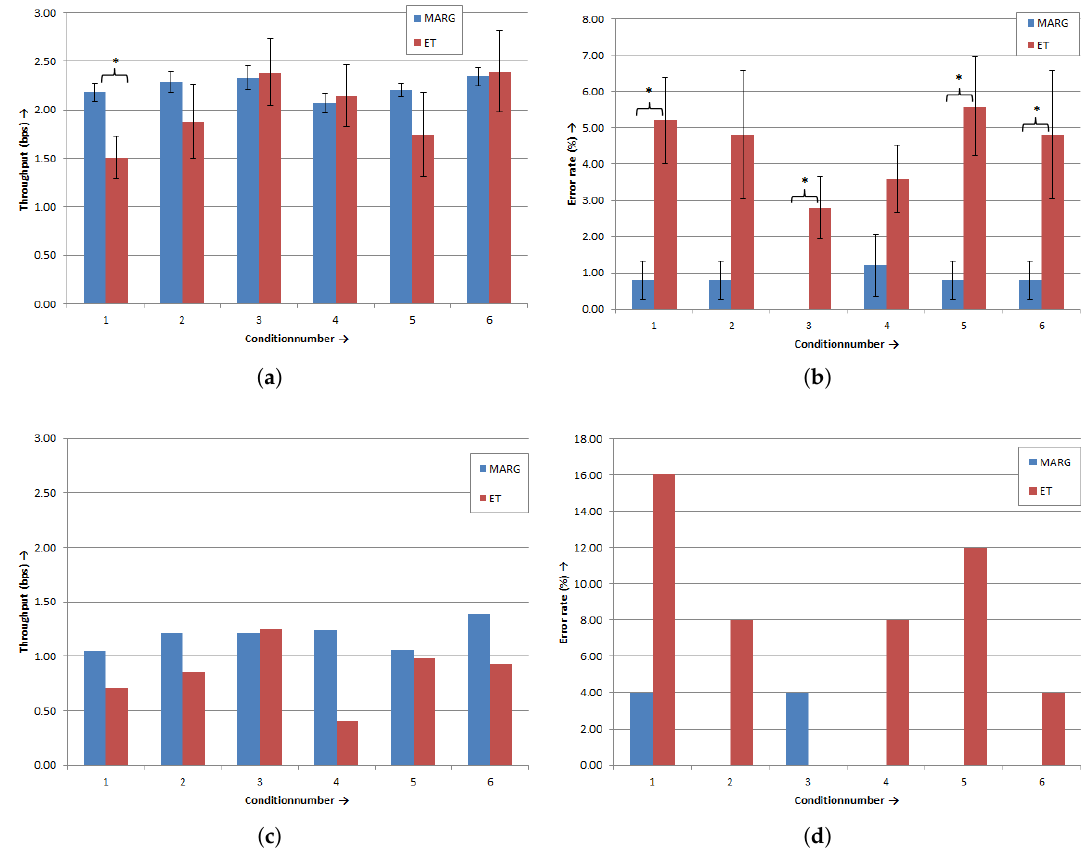
Figure 9. Results of the Fitts’s Law paradigm for the six conditions: ( a ) able-bodied subjects ( n = 10), mean throughput values ± SE; ( b ) able-bodied subjects ( n = 10), mean error rate values ± SE; ( c ) subject with tetraplegia ( n = 1), throughput values; and ( d ) subject with tetraplegia ( n = 1), error rate values. * Marks sig. differences ( p <